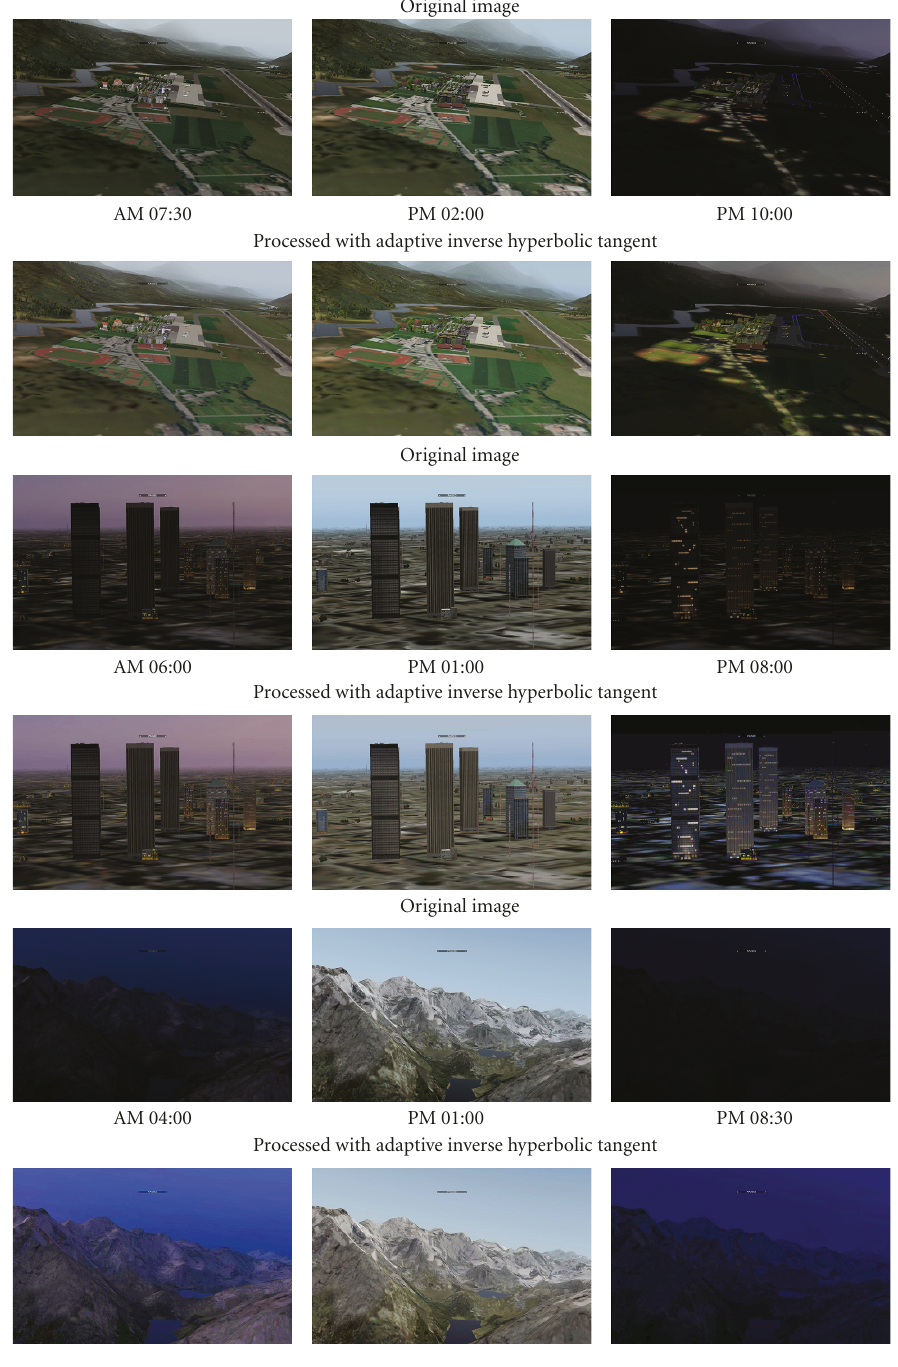
Figure 19: Capture images at di ff erent times of the contrast enhancement by our method.